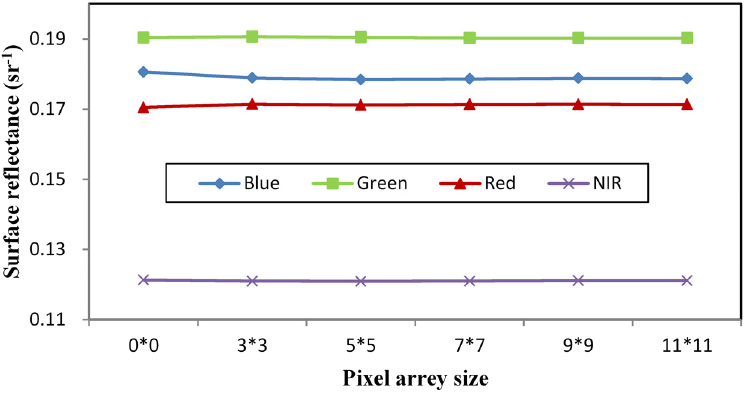
Figure 2. Average surface reflectance of nine samples in Lake Cihu with different pixel array